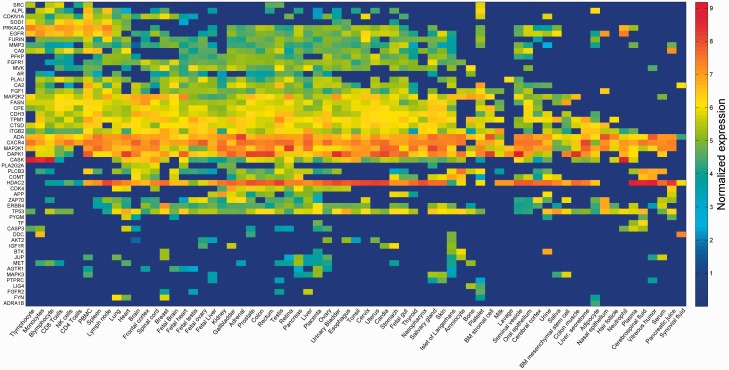
Averaged protein expression vectors. Representation of selected 53 genes averaged protein abundance vectors for the 69 anatomical entities in HIPED.